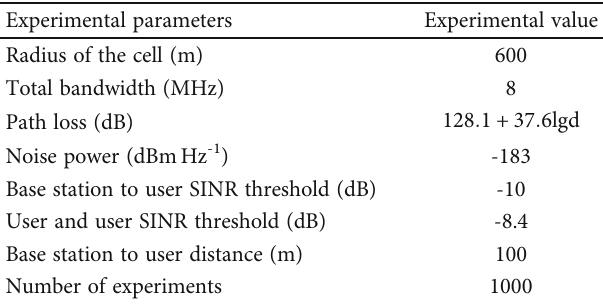
Table 1: Experimental